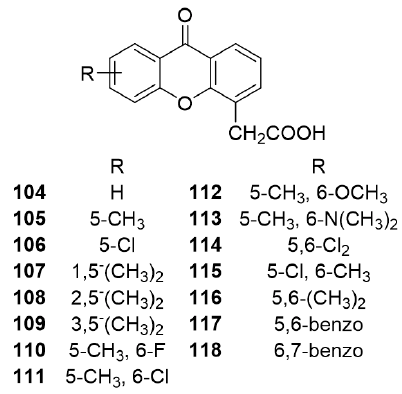
Figure 9. Structure of XAA ( 104 ) and analogues 105 – 118 .